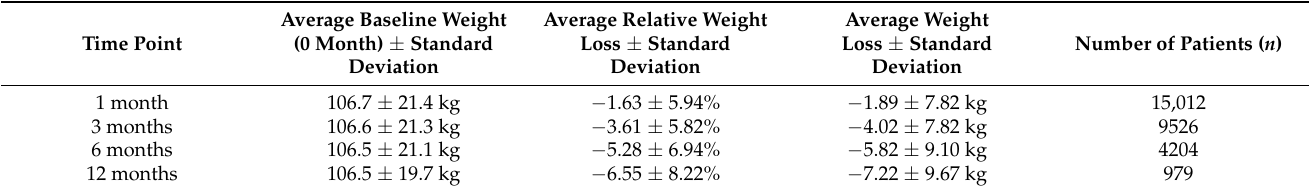
Table 2. Average relative and absolute weight loss (in percent and kg, compared to average baseline weight) at 1, 3, 6, and 12 months.